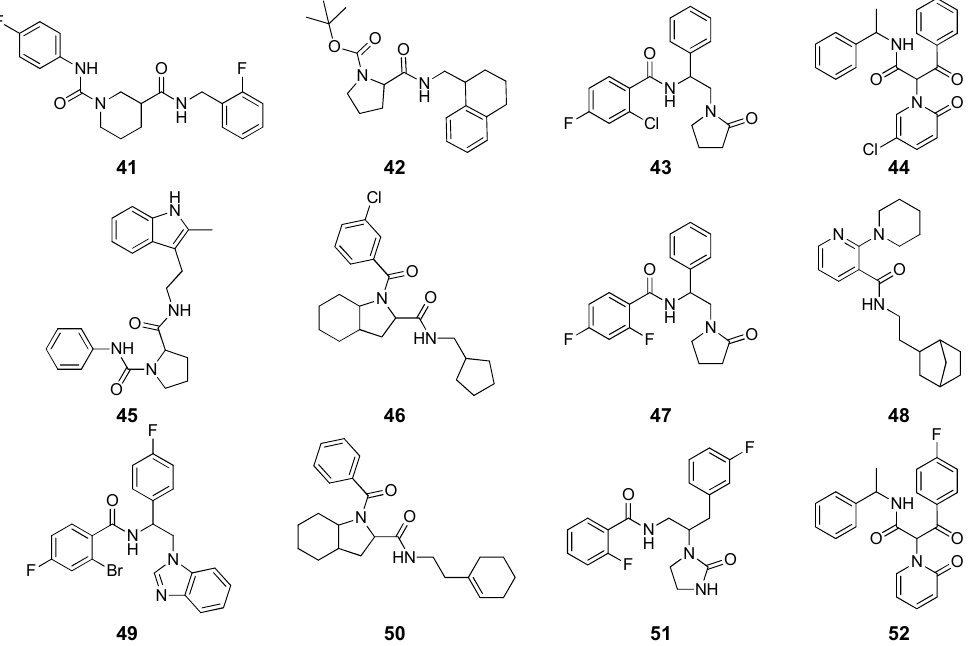
Figure 4. Structure of the 12 ligands selected through the VS study (compounds 41 – 52 ) performed by Nakagawa and co-workers. Table 2. Calculated binding free energies (kcal / mol) and experimental activities of the compound selected through the VS protocol performed by Nakagawa and co-workers. Compound N.